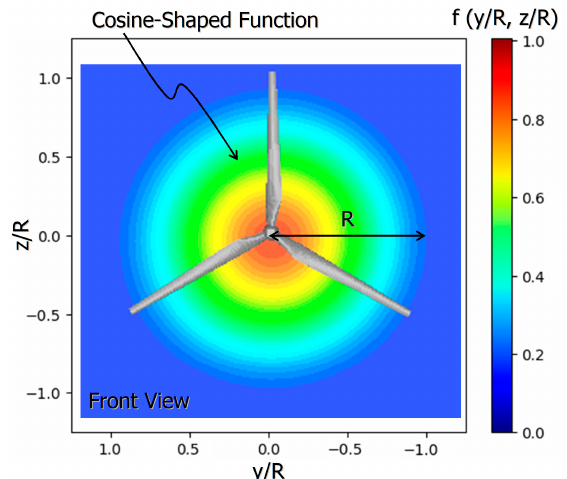
Figure 16. Image of the computational fluid dynamics (CFD) porous disk (PD) wake model proposed in the present study.